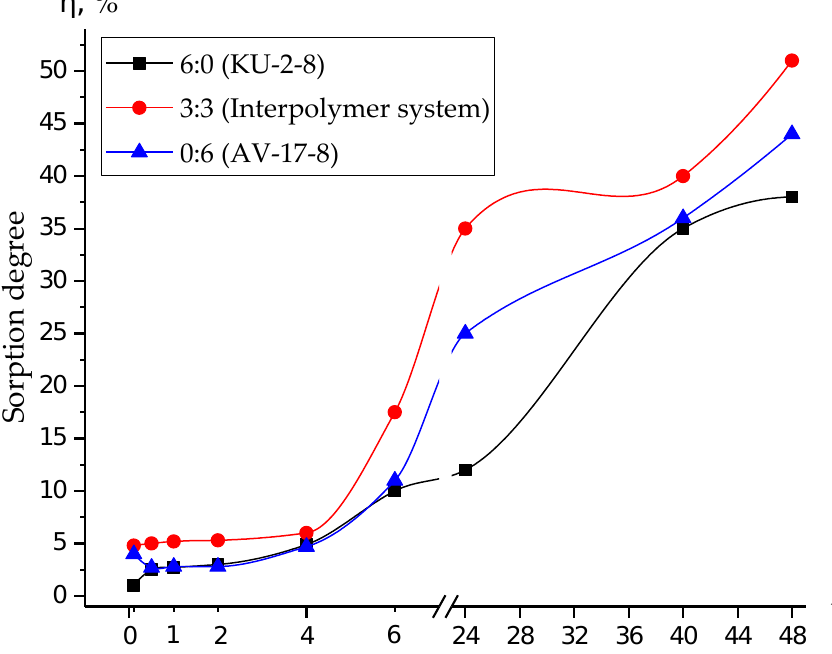
Figure 4. The dependence of the cerium ions sorption degree as a function of time. The activation of KU-2-8 and AV-17-8 ion exchangers showed that their swelling de- gree during the remote interaction was higher than the swelling degree outside the inter- polymer system “ KU-2-8 – AV-17- 8”. The increased swelling degree may indicate the im- provement in the permeability of polymers being in the interpolymer system, which